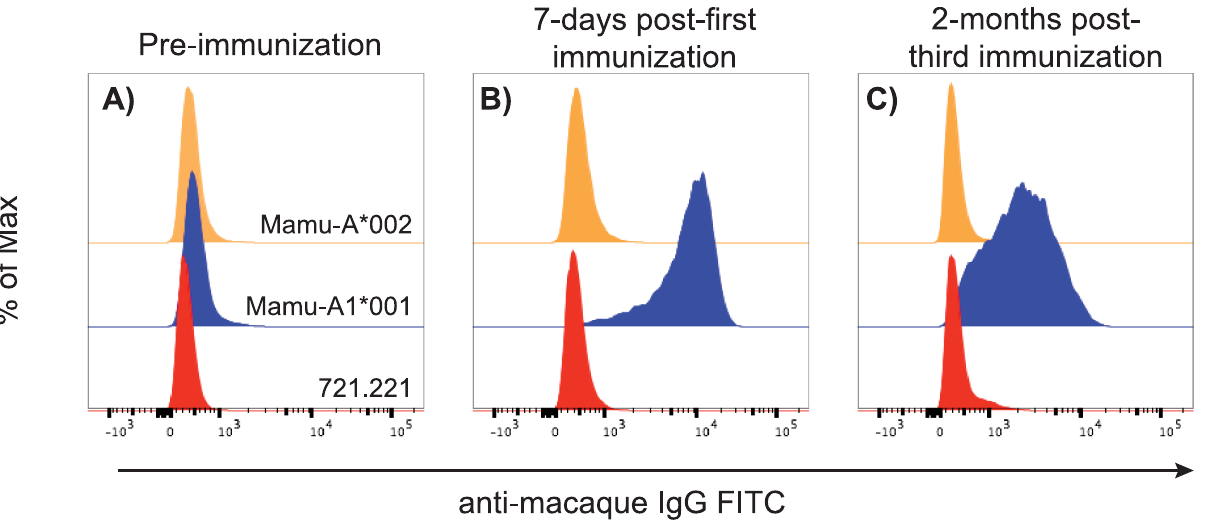
Fig 2. Screening serum of the alloimmunized macaque for Mamu-A1 * 001-binding antibodies. MHC class I transferents expressing only either Mamu-A1 * 001 or Mamu-A1 * 002 and the parentalMHC class I-null cell line (721.221)were incubatedwith (A) pre-, (B) 7-days post-, and (C) 2-months post-immunizationserum from the alloimmunized macaque.Cell-bound serum antibodies were detected with FITC- labeledanti-macaque IgG FITC.